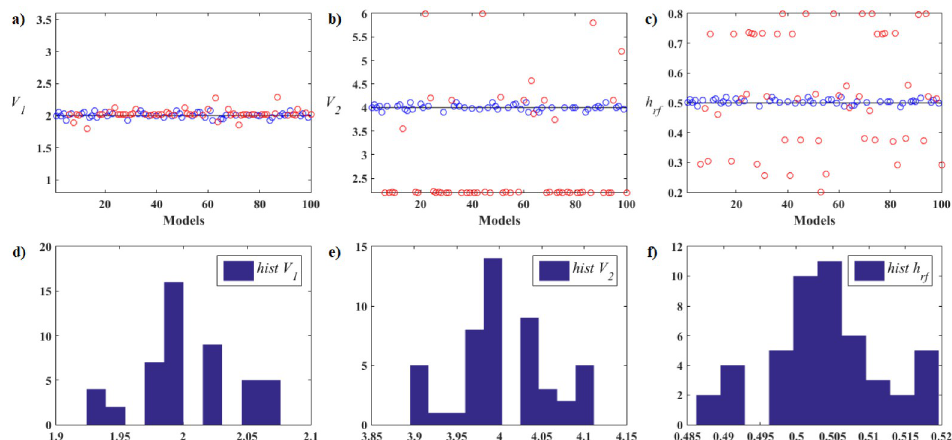
Fig 19. Case 1 (100 × 20). (a), (b), and (c) are all results obtained by the ANMS algorithm for variables V 1 , V 2 , and h respectively. Successful models are highlighted in blue and unsuccessful ones are in red. (d), (e), and (f) are their respective histograms.